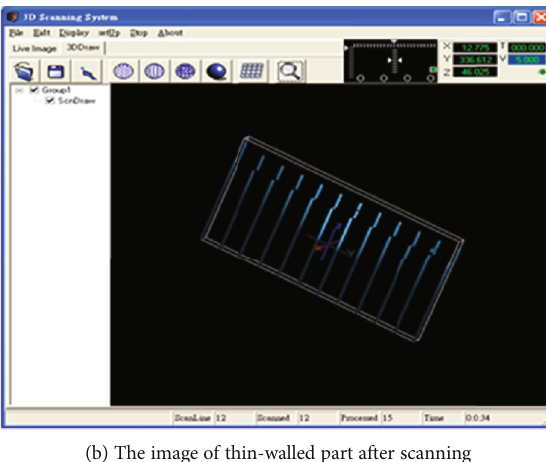
(a) The display of computer values after scanning